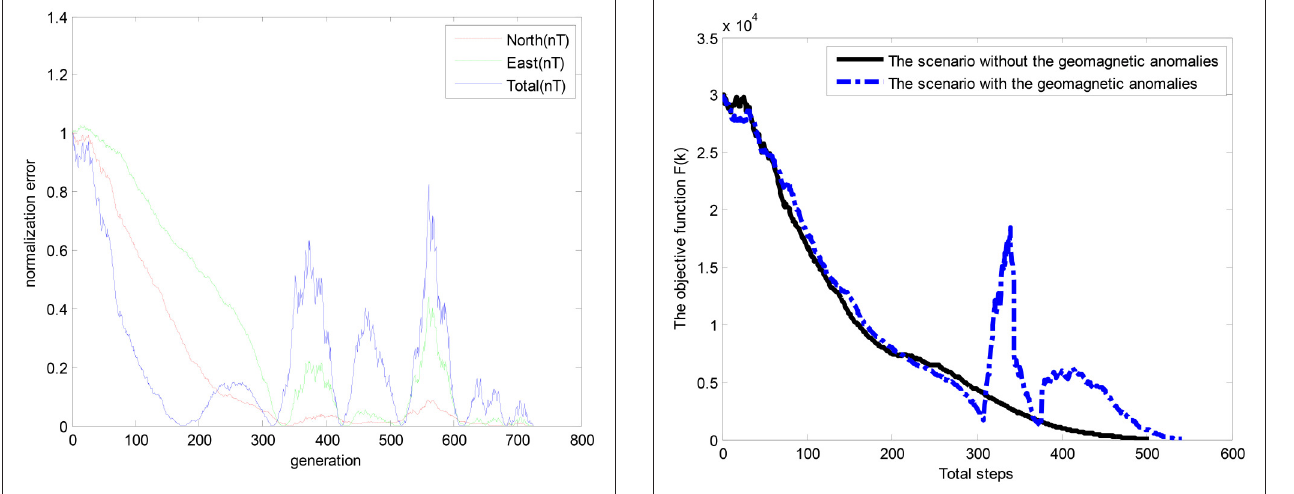
FIGURE 9 | The convergence of the objective